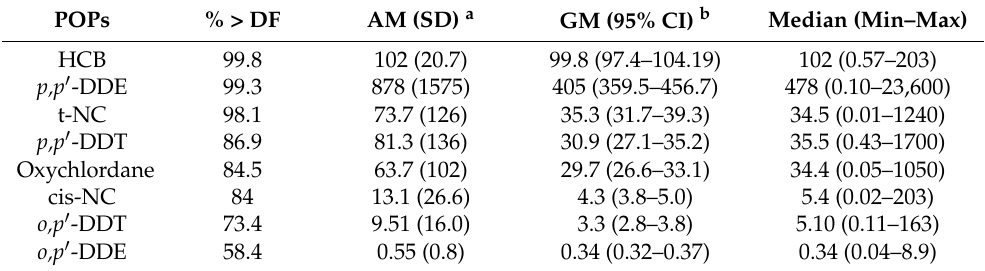
Table 1. Maternal serum concentrations (wet weight pg/mL) of POPs ( n =